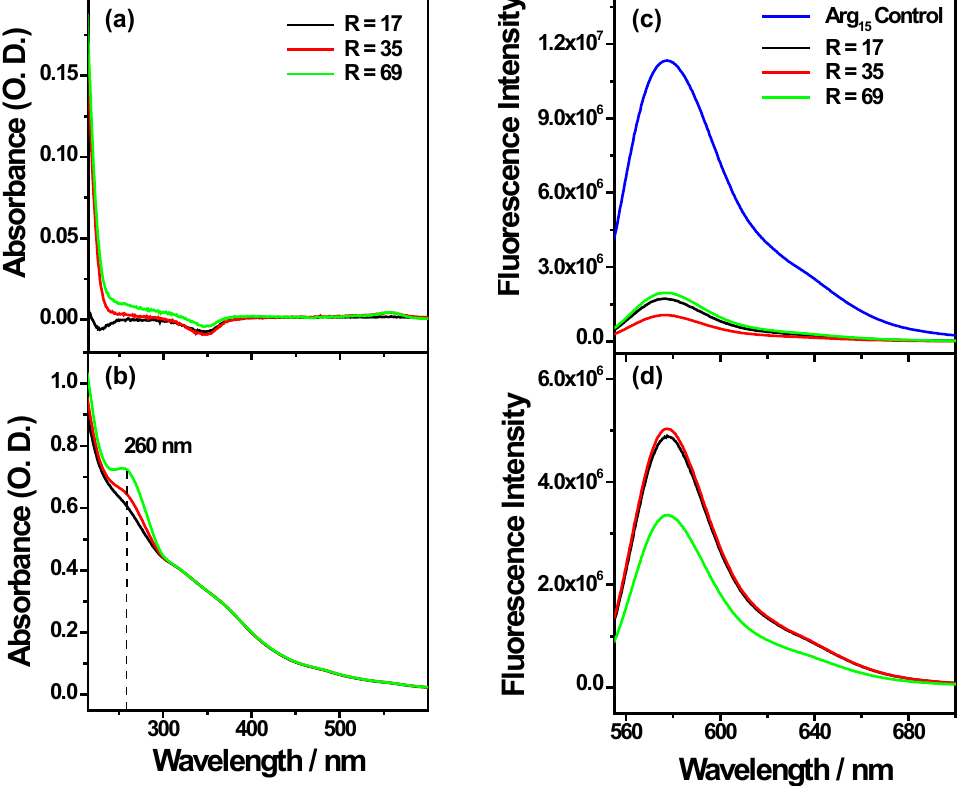
Figure 5. UV-visible (left) and fluorescence (right) spectra obtained for different values of R in water at pH 7 of ( a , c ) the supernatants; ( b , d ) the nanocomplexes (UV-visible spectra are normalized at 350